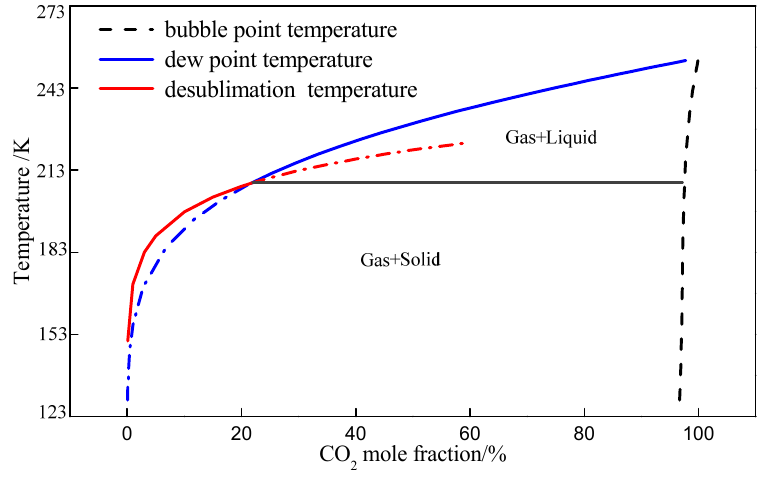
Figure 4. T - x curves of N 2 /CO 2 binary system at a pressure of 2 MPa.